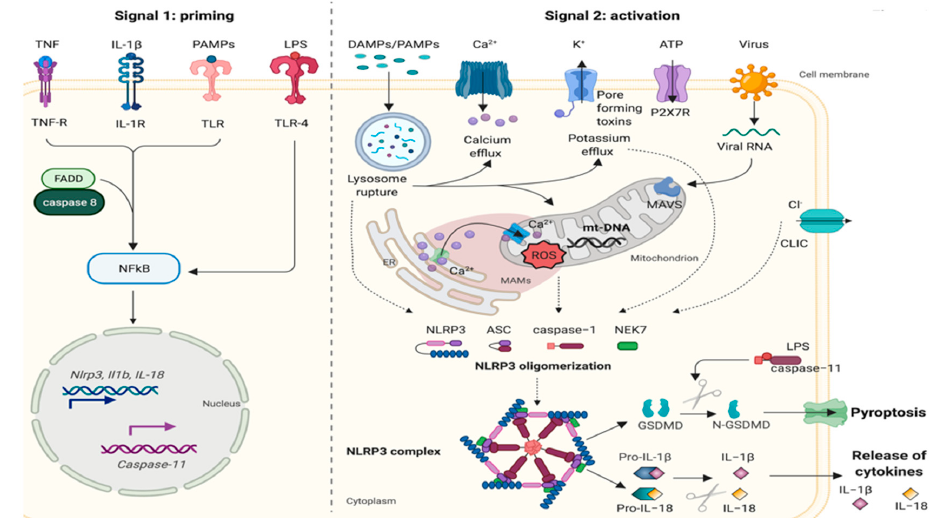
Figure 1. NLRP3 inflammasome priming and activation. The activation process of the NLRP3 inflammasome requires two main signals: (i) signal 1 (priming), which leads to the activation of the transcription factor NF- κ B and the subsequent transcription of canonical and noncanonical NLRP3 inflammasome components; and (ii) signal 2 (activation), which is responsible for NLRP3 complex assembly and the subsequent release of inflammatory cytokines (IL-1 β and IL-18). Priming is provided by exposure to pathogen-associated molecular patterns (PAMPs) such as lipopolysaccharide (LPS) or by endogenous cytokines that activate receptors at the cell membrane. The induction of NLRP3 expression during priming is controlled by FAS-associated death domain protein (FADD) and caspase-8. NLRP3 activation is provided by a plethora of stimuli, such as PAMPs or damage-associated molecular patterns (DAMPs), ATP, and viral RNA, that in turn trigger downstream signaling events such as mitochondrial damage, mitochondrial ROS production, lysosomal disruption, and ion (K + and Ca 2+ ) efflux. Mitochondrial antiviral signaling protein (MAVS) mediates the NLRP3 activation induced by RNA viruses. Excessive Ca 2+ released from the ER causes mitochondrial dysfunction and is implicated in NLRP3 inflammasome activation. Chloride intracellular channel protein (CLIC)-mediated Cl - efflux promotes the NEK7-NLRP3 interaction and subsequent NLRP3 inflammasome assembly. LPS can directly activate TLR4 to induce the transcription and activation of caspase-11, which in turn cleaves the pore-forming protein gasdermin D (GSDMD), which can induce pyroptosis. IL-18: interleukin-18; IL-1 β : interleukin-1beta; IL-1R: interleukin 1 receptor; mt-DNA: mitochondrial DNA; ROS: reactive oxygen species; TLR: Toll-like receptor. Created with BioRender.com accessed on 30 March